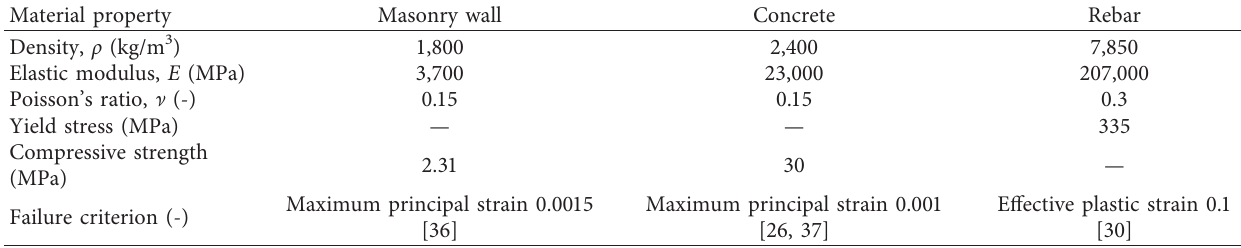
Table 1: Constitutive model parameters of the building